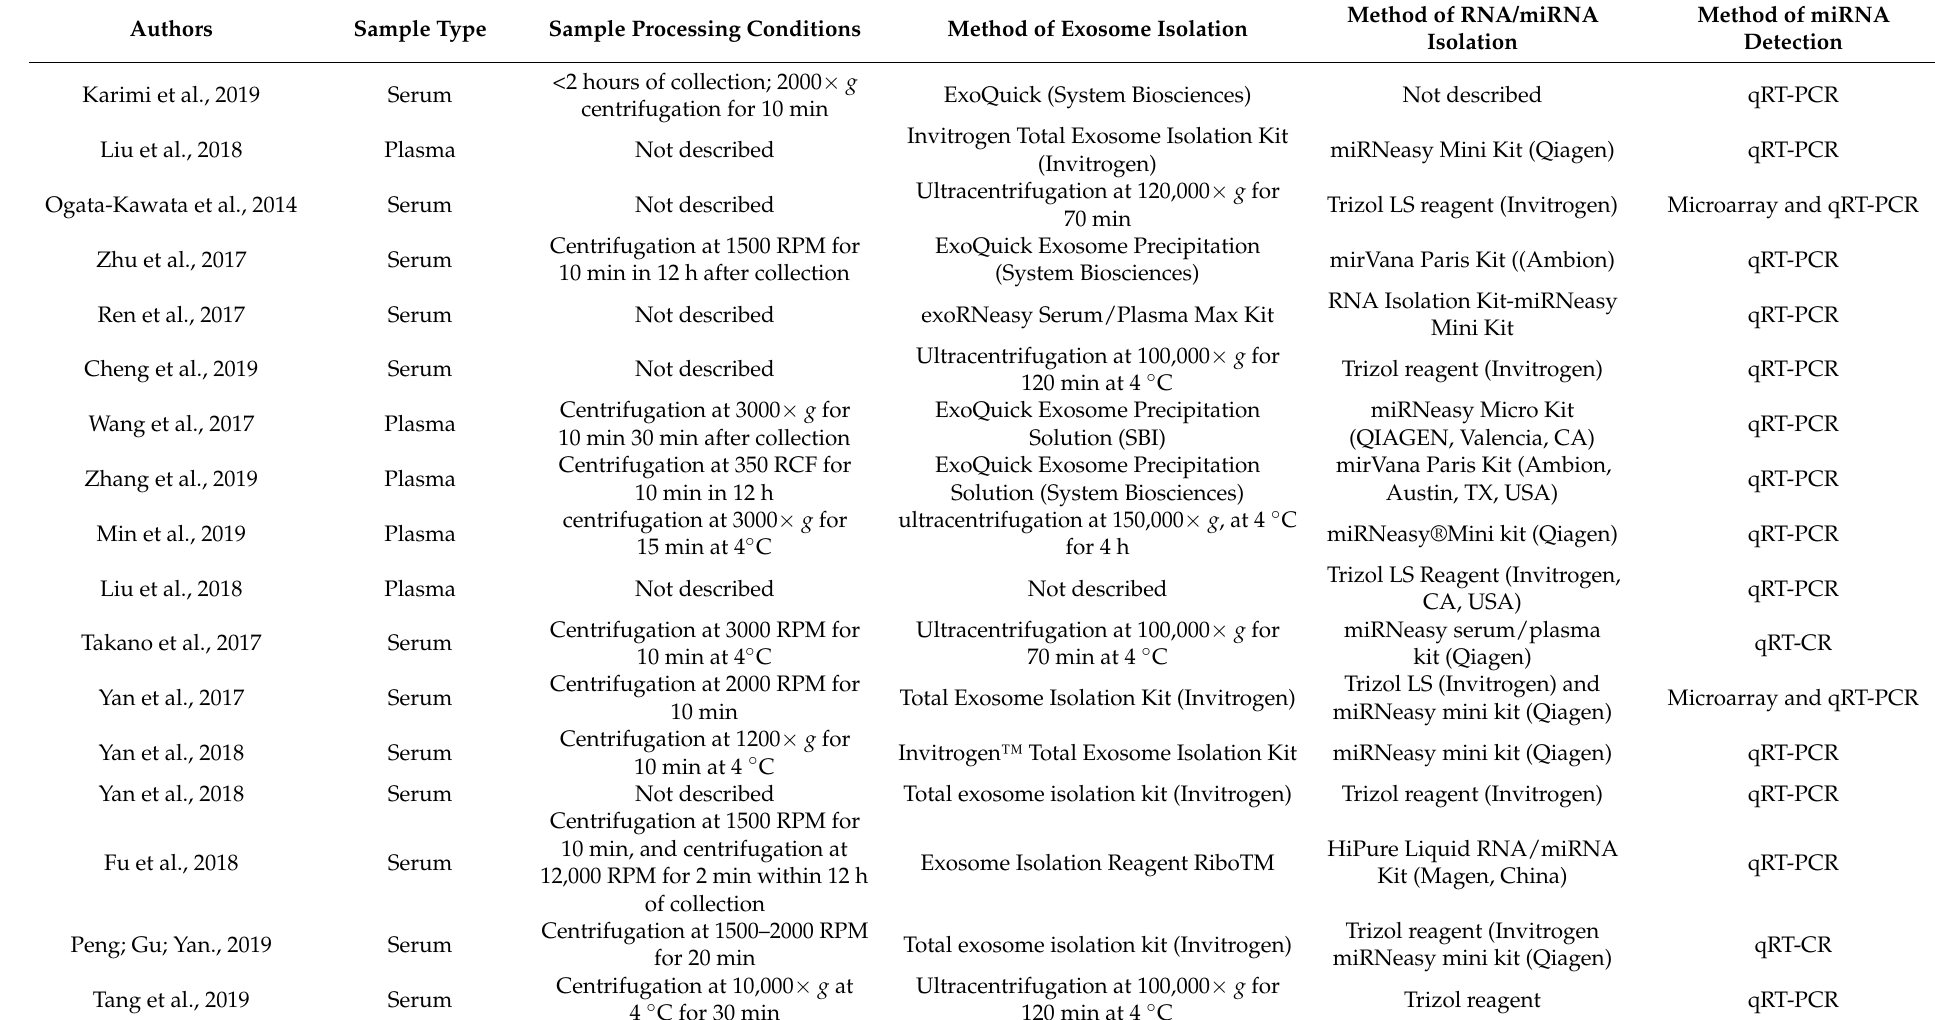
Table 1. Review of sample protocols, isolation methods, detection and validation of exosomal miRNAs in the